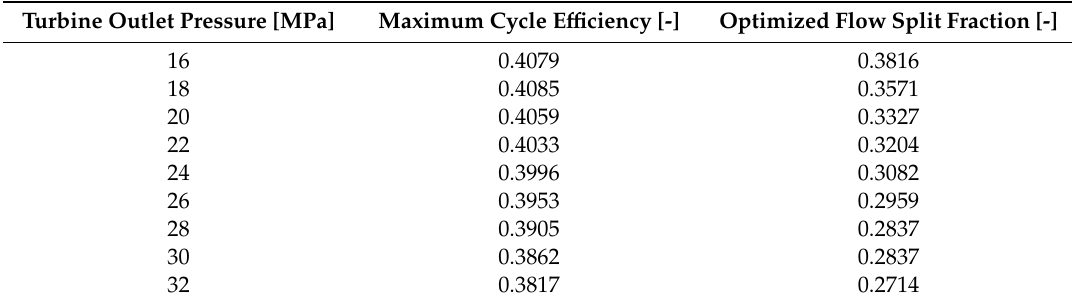
Figure 3. Cycle efficiency versus flow split fraction under different compressor outlet pressure values. Compressor inlet pressure is 7.4 MPa, temperature 31.25 ◦ C and turbine inlet temperature is 487 ◦ C. Table 1. Flow split versus compressor outlet pressure (compressor inlet pressure is 7.4 MPa, temperature 31.25 °C and turbine inlet temperature is 487 °C).